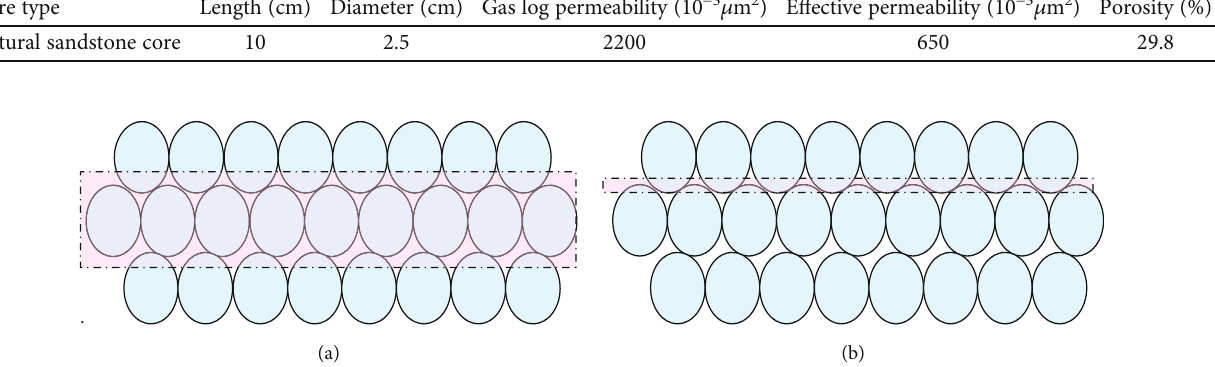
Figure 2: Di ff erence between conventional and frozen production. (a) Conventional slicing method (room temperature production). (b) Frozen production method (liquid nitrogen frozen